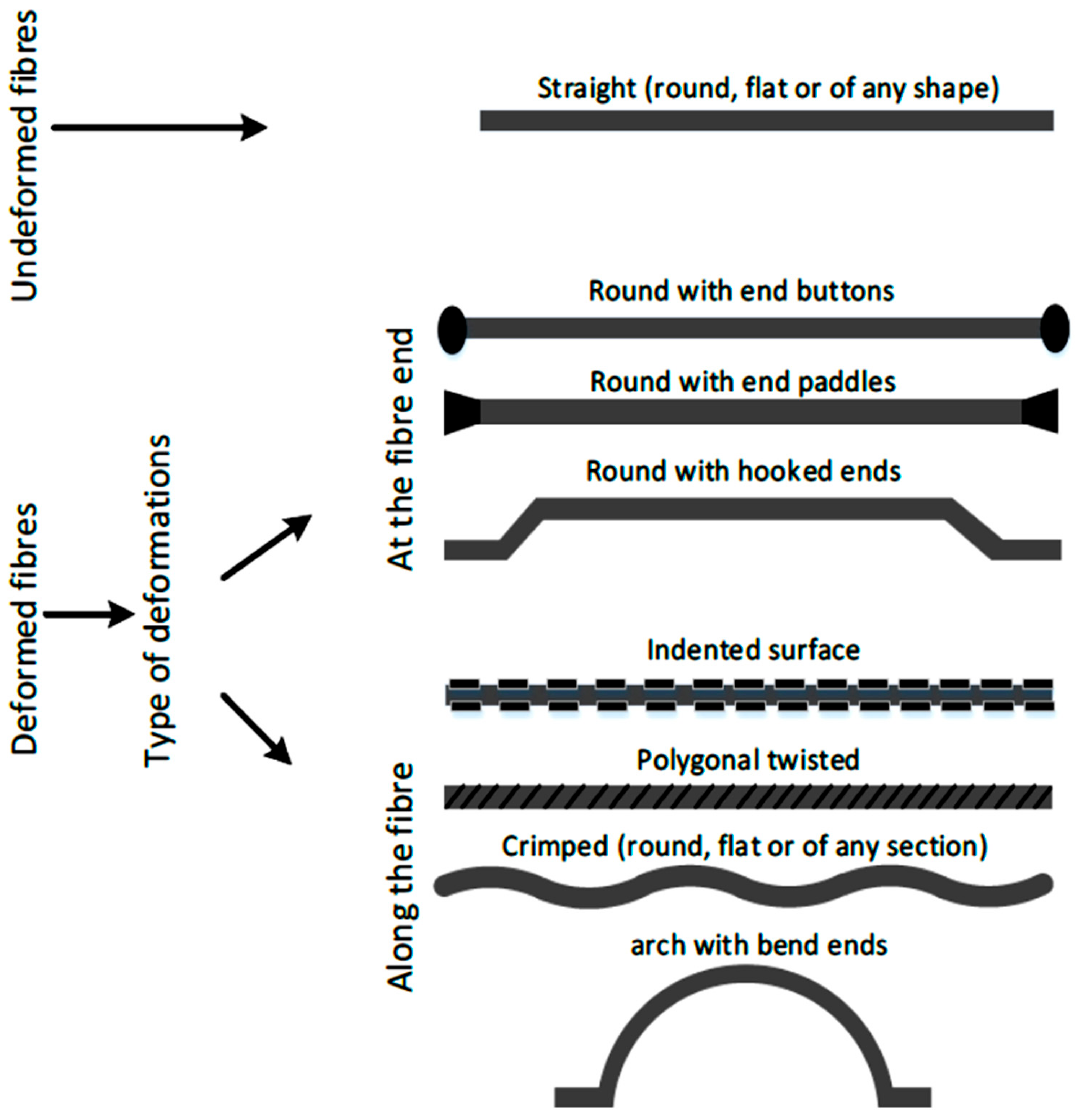
Figure 7. Various steel fibres, categorised according to their geometric shape [40].